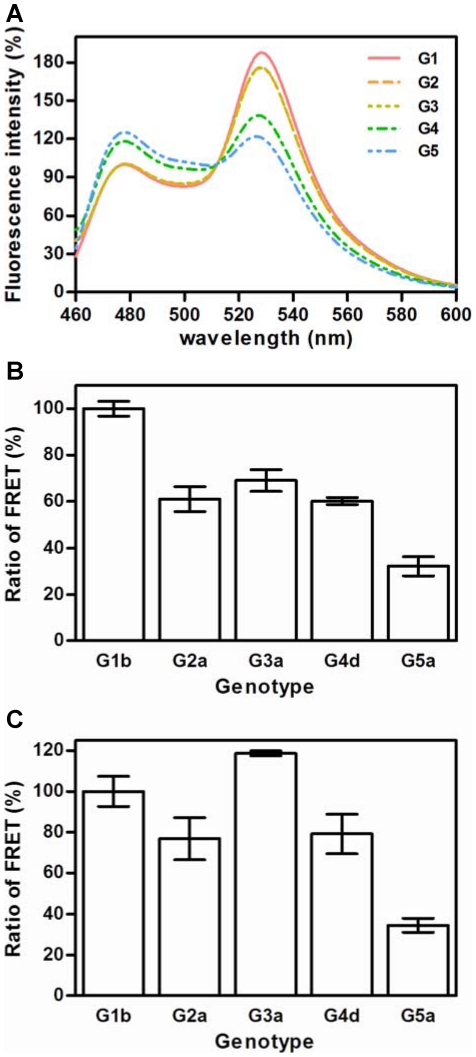
NS5B oligomerization of genotypes 1 to 5.A) Spectra obtained for a representative FRET experiment. Proteins NS5BΔ21 fused to cyan and NS5BΔ21 fused to citrine were mixed at eqimolar concentration in FRET buffer. Then, the mixture was excited at 432 nm and spectra were recorded from 460 nm to 600 nm. Two main peaks were obtained, one corresponding to cyan at approximately 478 nm and the other at approximately 530 nm corresponding to citrine. FRET ratios were calculated as the ratio of the 530 nm and 478 nm intensities. B) FRET ratios for the interaction of eqimolar amounts (50 nM each) of NS5BΔ21-cyan and NS5BΔ21-citrine for each genotype are shown. Spectra were obtained in the presence of 10 mM NaCl and 4.5 mM Mg(CH3COO)2. Values are normalized against the ratio obtained for NS5BΔ21-1b and expressed in percentage. Results are the mean and SEM of twelve independent experiments. C) FRET ratios were calculated as described above, unless spectra were obtained in the presence of 66 mM NaCl and 5 mM MnCl2. Ratios are normalized against the ratio obtained for NS5BΔ21-1b, and expressed in percentages. Values are the mean and SEM of six independent experiments.